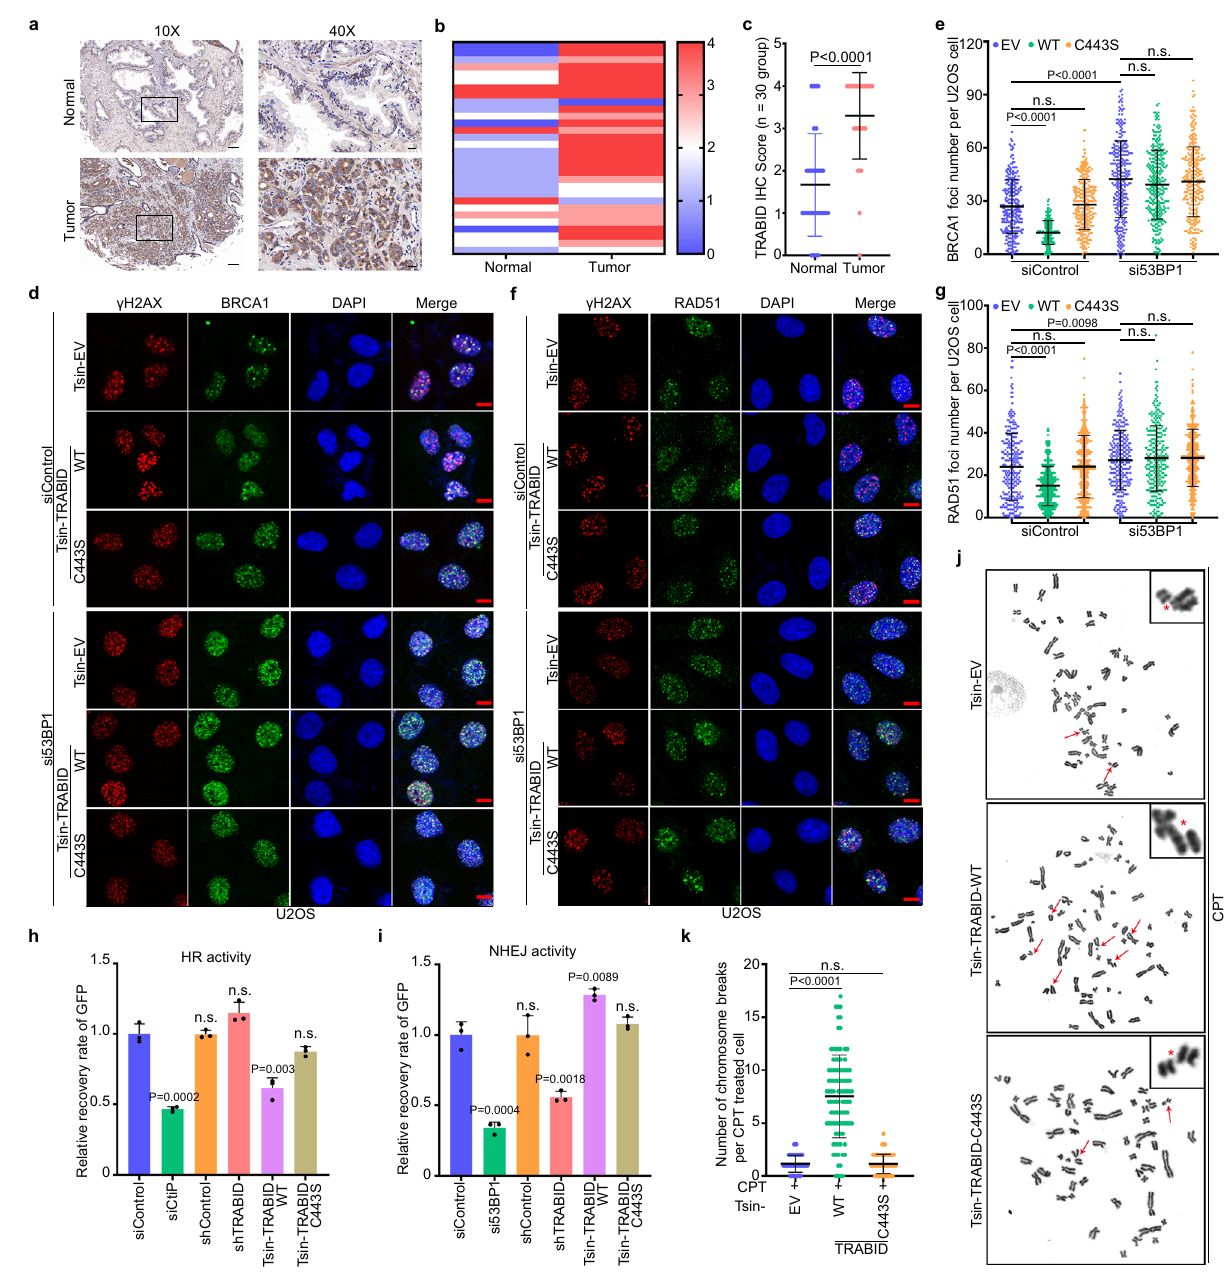
Fig. 5 | TRABID overexpression inhibits HR activity and promotes chromoso- mal instability. a – c Representative images of IHC staining ( a ) of TRABID protein on paired prostate cancer patient specimens ( n =30). Scale bar in 10 X fi elds: 100 μ m; Scale bar in 40 X fi elds: 20 μ m. Heat map showing TRABID IHC score in normal and paired tumor tissues (see calculation details in Methods) ( b ). Quanti- fi cation of IHC score ( c ). Data were shown as the mean±SD of three independent experiments( n =3).Two-tailedunpairedStudent ’ s t -test. P =5.3E-7. d – g U2OScells infected with lentivirus expressing EV, TRABID-WT, or TRABID-C443S and treated with siControl or si53BP1 were exposed to IR followed by IFC of BRCA1 ( d ) and RAD51( f )at1hafterIR.Scalebar,10 µ m.Theaveragefocinumber( e , g )ineachcell were quanti fi ed. Data were presented as means±SD of more than 300 cells from threebiologicalreplicates.Two-tailedunpairedStudent ’ s t -test.n.s.notsigni fi cant. P valuesbasedonthe orderofappearance: e (2.5E-54, 0.3363,1.9E-22, 0.0659,and 0.4015), g (1.9E-16, 0.9275, 0.0098, 0.4221, and 0.3285). h , i PC-3 cells were